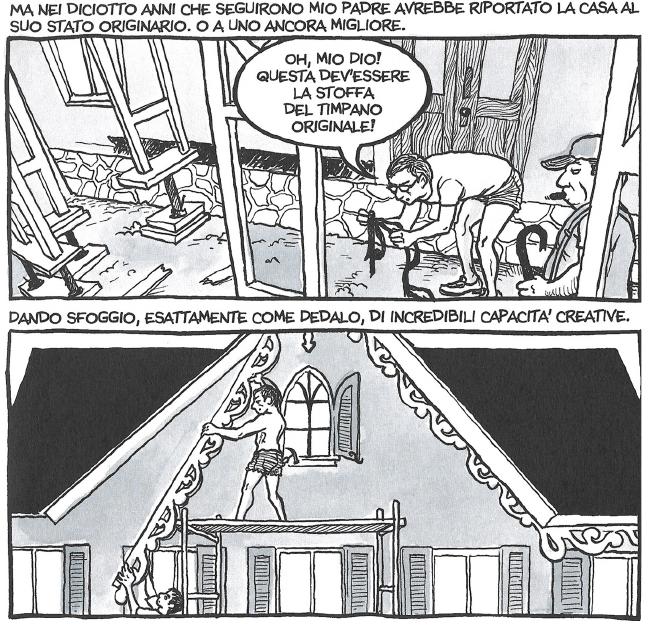
Home that portrays Bruce Bechdel intent on renovating the family home (Bechdel, 2007, p.